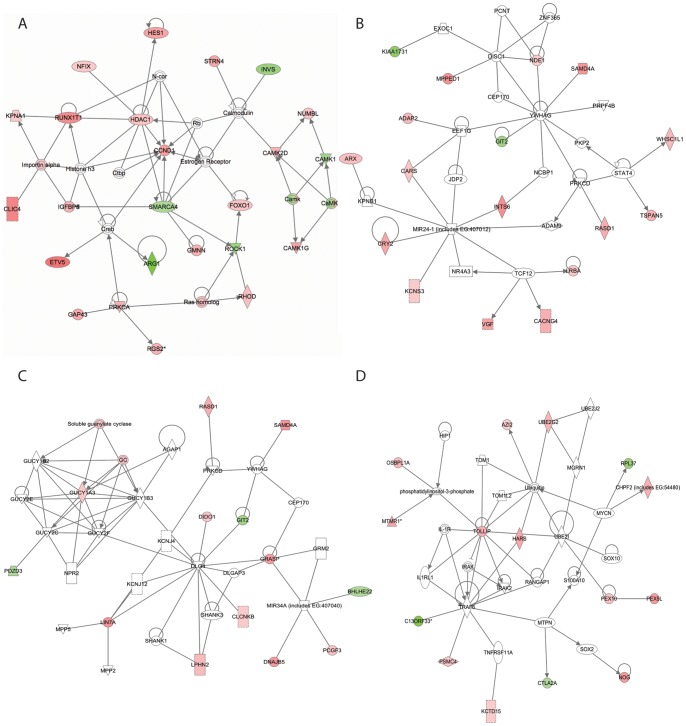
IPA network analysis at 5 h.The three highest scoring networks from LRG list are shown. Red, upregulated genes; green, downregulated genes. White open nodes, genes not present in LRG set but that interact with LRGs, as identified by the IPA Knowledge Base. A solid line denotes a direct functional interaction of the products of the two genes. A dotted line denotes an indirect interaction. An arrow indicates that a gene product “acts on” a target. *, Multiple affymetrix identifiers map to a single gene.